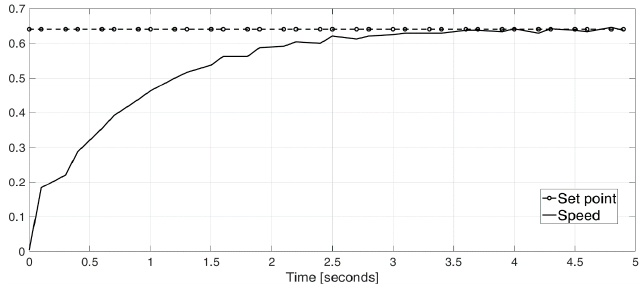
Figure 9. PID implementation results speed (P.U.).